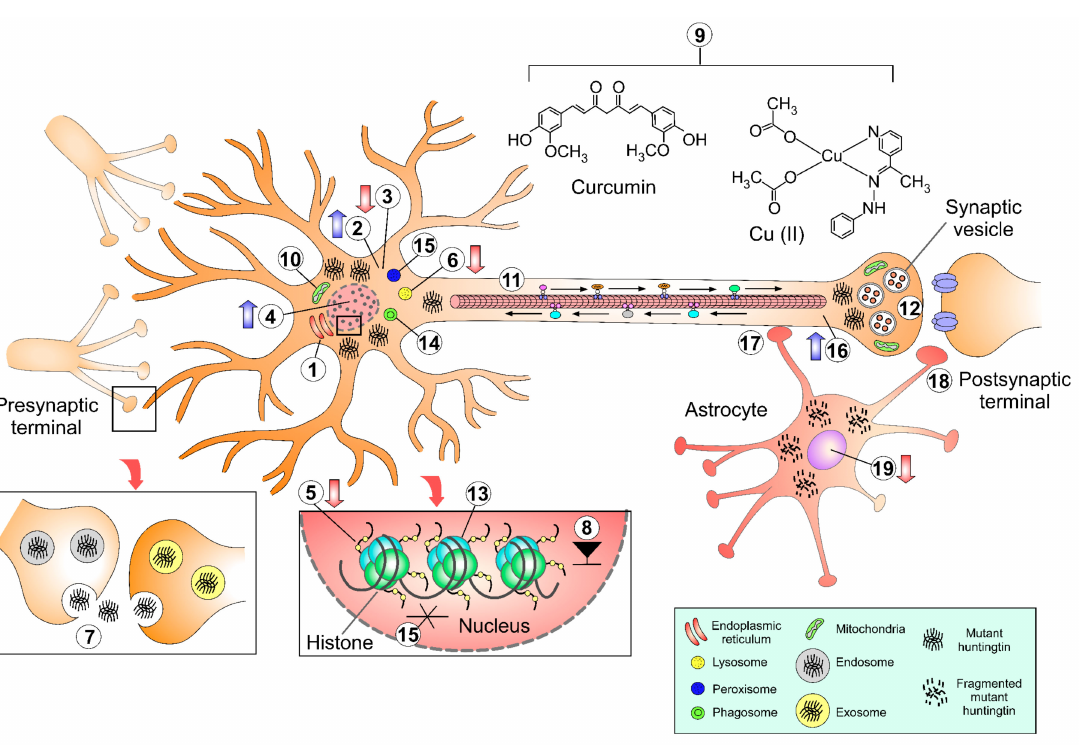
Figure 3. Some examples of the legacy of the fruit fly in solving molecular questions in Huntington’s disease. Numbers are related to the conclusions of this review. Upwards arrows (blue) indicate increasing expression. Downwards arrows (red) indicate decrease in